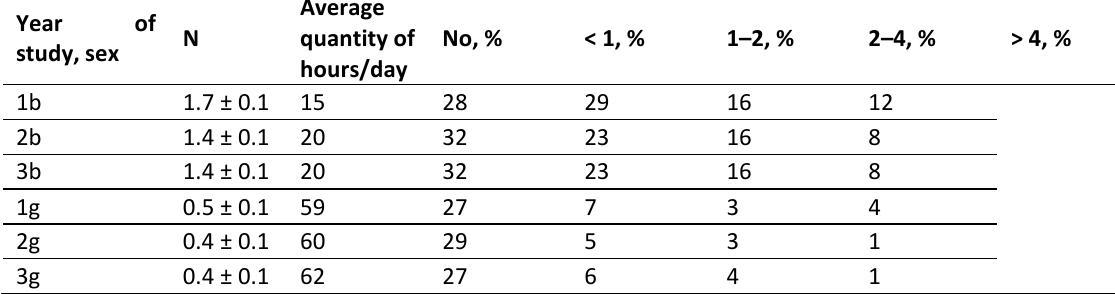
Table 2. Distribution of students by time (hours/day), spent for computer games